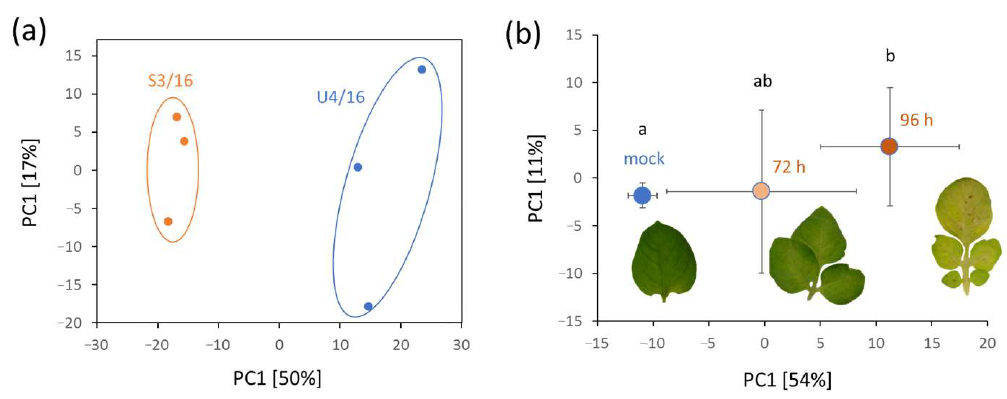
Figure 4. Phytophthora infestans peptide-based detection in mycelium and in planta. ( a ) Separation of proteome profiles of two independent isolates used for the evaluation P. infestans mycelium proteome. Based on relative abundances of most abundant proteins (786 identified proteins with at least two unique peptides); ( b ) representative images of plant material and separation of proteome profiles of S. tuberosum leaf 72 and 96 h after inoculating with P. infestans. Presented data visualized by PCA are means and standard deviation ( n = 5), di ff erent letters indicate significant di ff erences (Kruskal–Wallis test, p < 0.05). Based on relative abundances of most abundant proteins (408 identified proteins with at least two unique peptides).